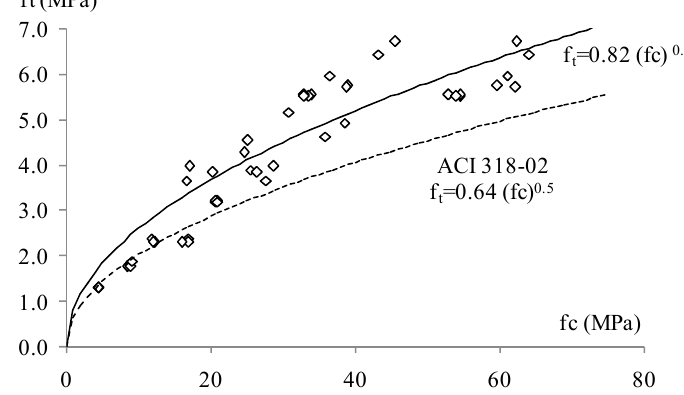
Figure 4. The f t (f c ) relationships for fly-ash geopolymer mortars 10N, 30N, and 50N, compared with the ACI 318-02 square root equation for geopolymer binders.